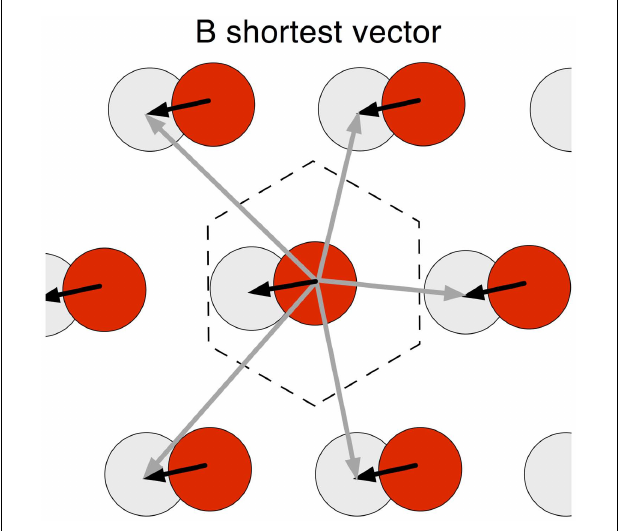
FIGURE 3 | Shortest interbump vector (SIV). In a rigid module, the vectors connecting the bump of a grid cell to the activity bumps of a second cell are fixed.The figure illustrates the activity pattern of a single grid cell (red) with a bump in the center, and the vectors to activity bumps of a second grid cell (gray). For the central red bump – and any red bump – there are six vectors to the nearest six bumps of the gray cell activity map: the shortest is black and the others are dark gray.The SIV is constant for all red cell activity bumps. A single gray bump falls within a hexagonal tile centered on the red